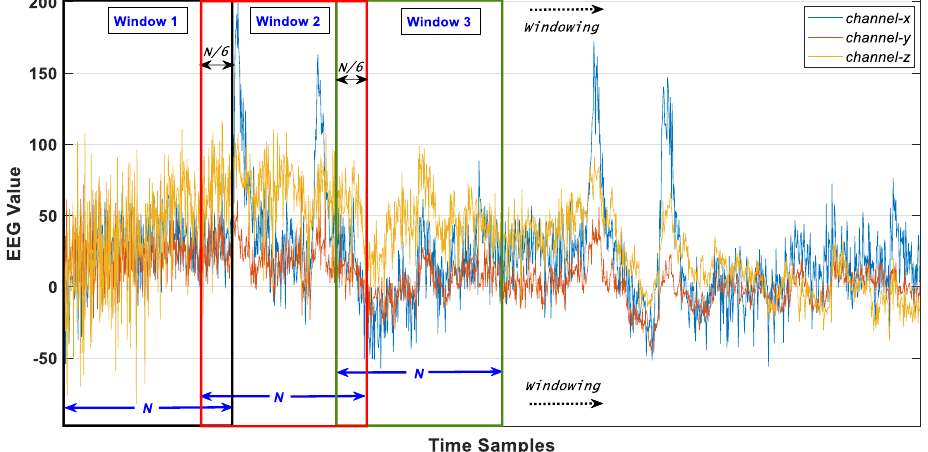
Figure 1. Windowing with overlapping on raw electroencephalogram (EEG) data.